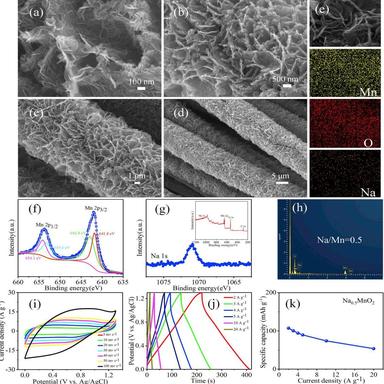
a-d) SEM at low and high magnifications and e) EDS element mapping images of Na0.5MnO2 NWAs. High-resolution f) Mn 2p and g) Na 1s XPS spectra of the Na0.5MnO2 NWAs (inset in g: XPS survey spectrum). h) EDS spectra of the Na0.5MnO2 NWAs. i) CV curves, j) GCD performance and k) the specific capacity of the Na0.5MnO2 NWAs electrode.